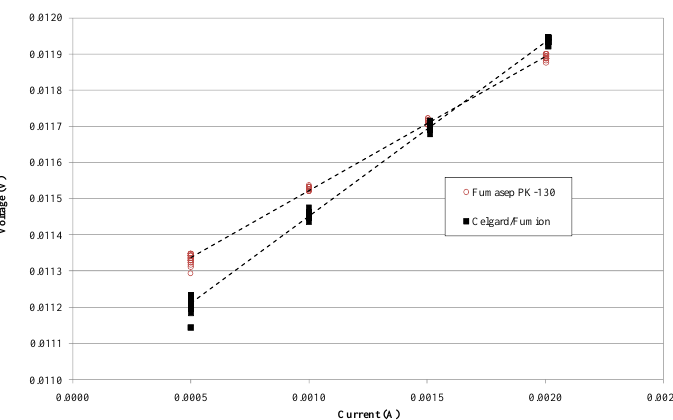
Figure 6. Voltage vs. current measurement on Fumasep-PK-130 ( ○ ) and Celgard/Fumion ( ■ ) membrane in NaCl 0.5 M at 25 °C. Table 2. IEC and conductivity of sample membranes.